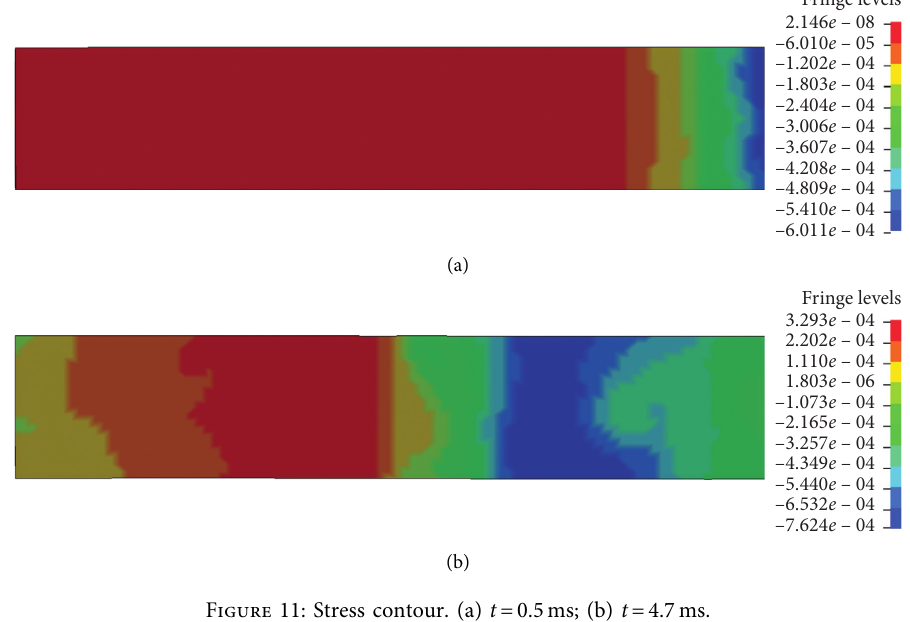
Figure 11: Stress contour. (a) t � 0.5ms; (b) t � 4.7 ms.